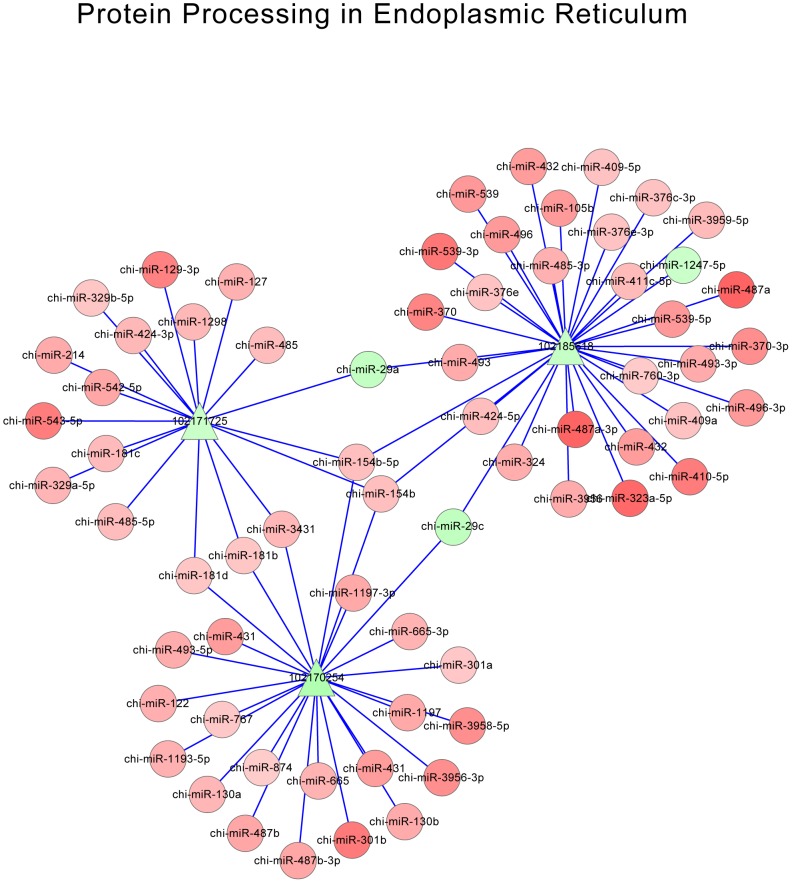
Network of protein processing in endoplasmic reticulum.Red triangle: up-regulated DE-targets; Green triangle: down-regulated DE-targets; Red roundness: up-regulated miRNAs; Green roundness: down-regulated miRNAs. The deeper the color, the stronger the trend.